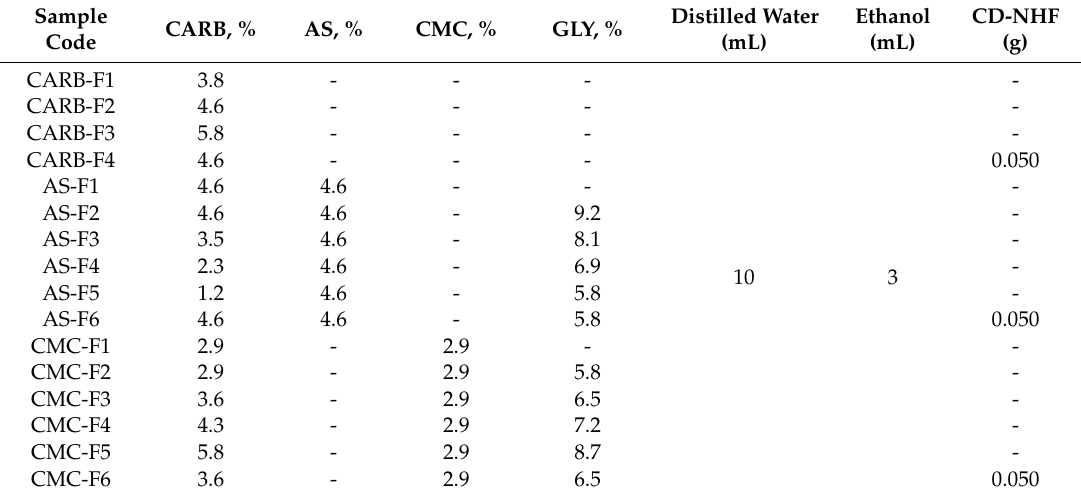
Table 1. Polymeric composition of various CARB, AS, and CMC gel formulations. CARB: carbomer Ultrez 10; AS: sodium alginate; CMC: carboxymethyl cellulose; GLY: